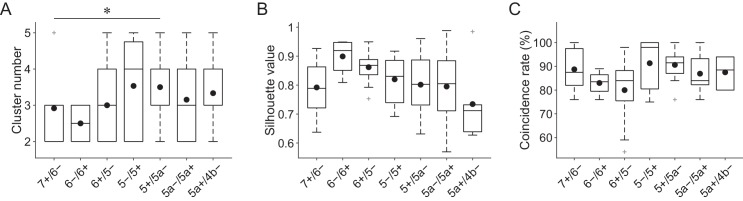
Summary of correspondence between functional boundaries and AldC expression.(A) Number of clusters per field of view for all sessions from all mice (n = 5, 3, 8, 9, 8, 3, and two mice, 12, 4, 13, 15, 16, 13, and 6 sessions for 7+/6−, 6−/6+, 6+/5−, 5−/5+, 5+/5a−, 5a−/5a+, and 5a+/4b− boundaries, respectively). (B) Same as in panel (A), but for silhouette values for the clustering results. (C) Same as in panel (A), but for coincidence rates for the clustering results. One-way ANOVA on ranks with repeated measures followed by post-hoc Tukey’s test: *p<0.05.10.7554/eLife.47021.014Figure 2—figure supplement 4—source data 1.Datasets used to create Figure 2—figure supplement 4.